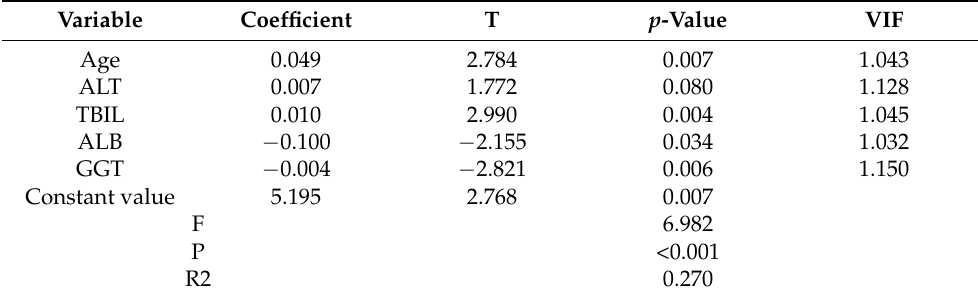
Table 4. Multiple linear regression analysis of voriconazole trough concentration